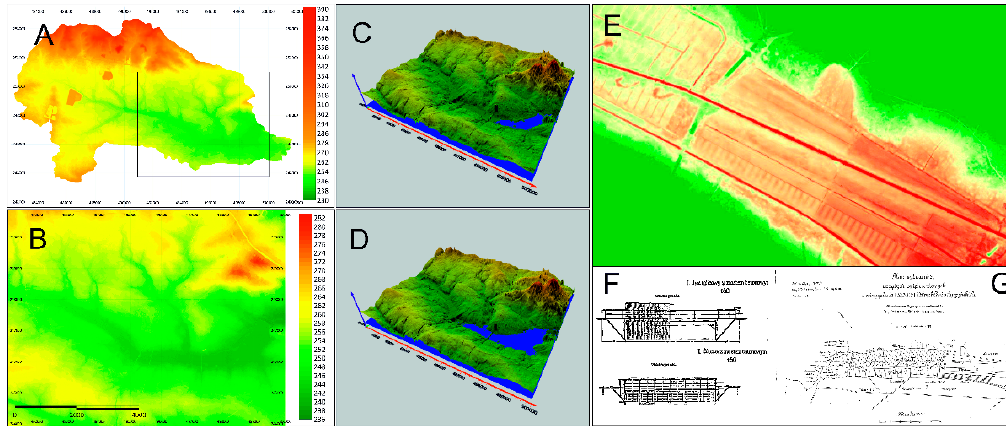
Figure 3. History of the Gostynia River catchment area: Digital Terrain Model of primary catchment area of the Paprocany reservoir ( A ); part of the Paprocany catchment area with the Paprocany reservoir ( B ); 3D model of the catchment area of the Paprocany reservoir at a normal damming level of 242.15 m a.s.l. ( C ) and 3D model of the catchment area of the Paprocany reservoir in the primary damming level of (244.15 m a.s.l.); with visible seepage channels of the root and plant treatment works ( E ); needle weir from 1873, original renovation plan from 1931 ( F ); and original plan of drainage and collection channels from renovation period in 1931 ( G ). 3D image model (C and D) was carried out on the basis of DTM data using the Surfer 18 Golden Software.